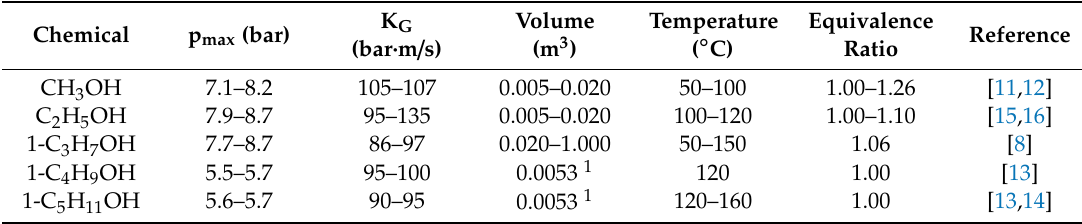
Table 1. Published p max and K G